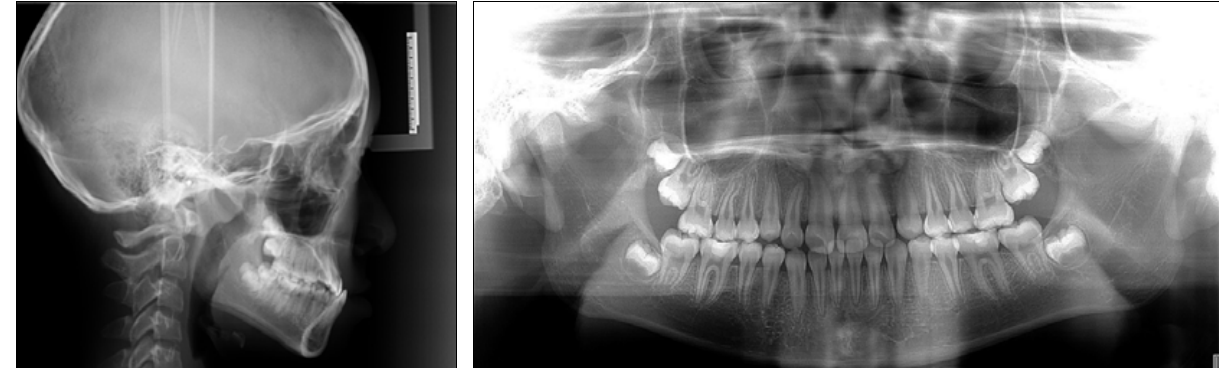
Figure 3. Pretreatment